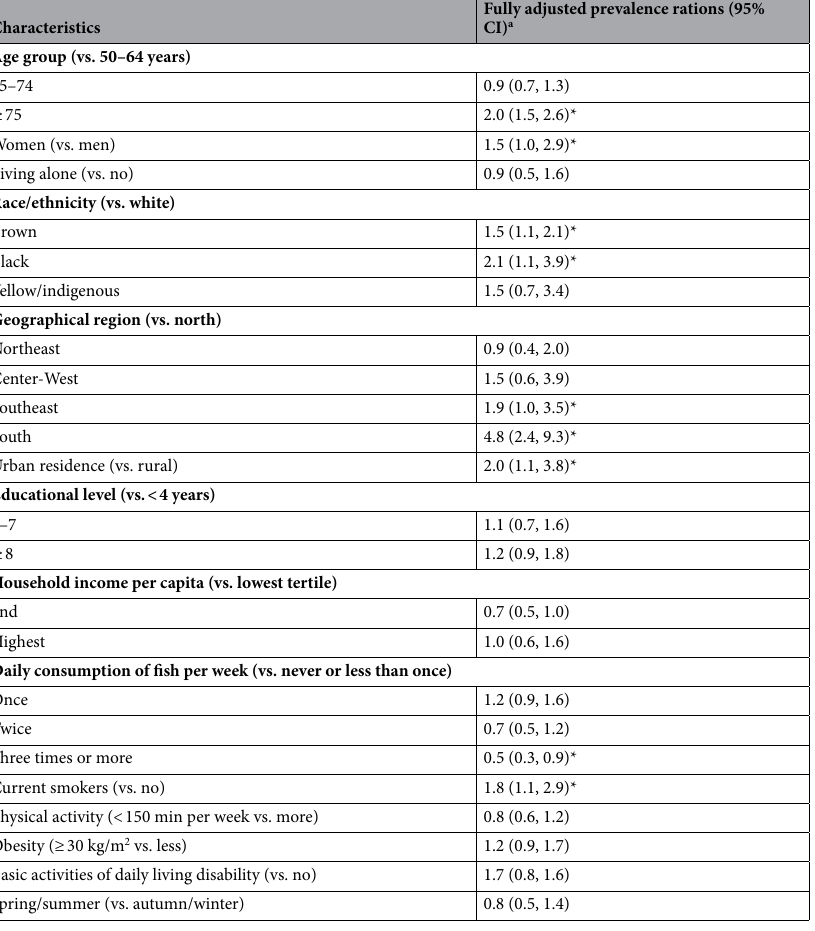
Table 3. Multivariate analysis of factors associated with serum 25-hydroxyvitamin D concentration below 50 nmol relative to concentrations equal to 50 nmol or over in participants of the Brazilian Longitudinal Study of Aging (ELSI), 2015–16. *p < 0.05. a Estimated by Poisson regression, and simultaneously adjusted for all variables listed in the